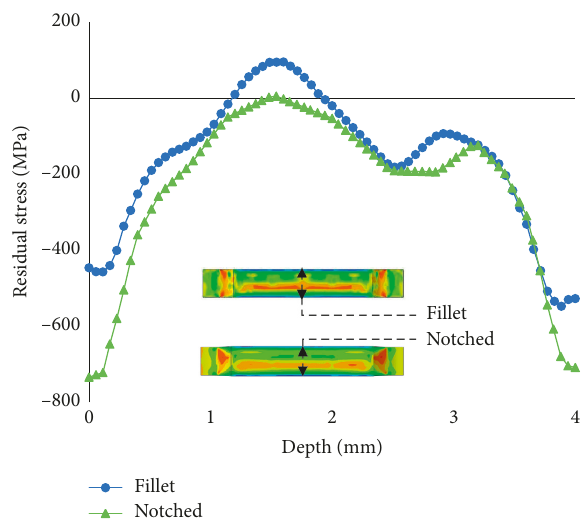
Figure 9: MEF simulation results of residual stress distribution in depth at midpoint of